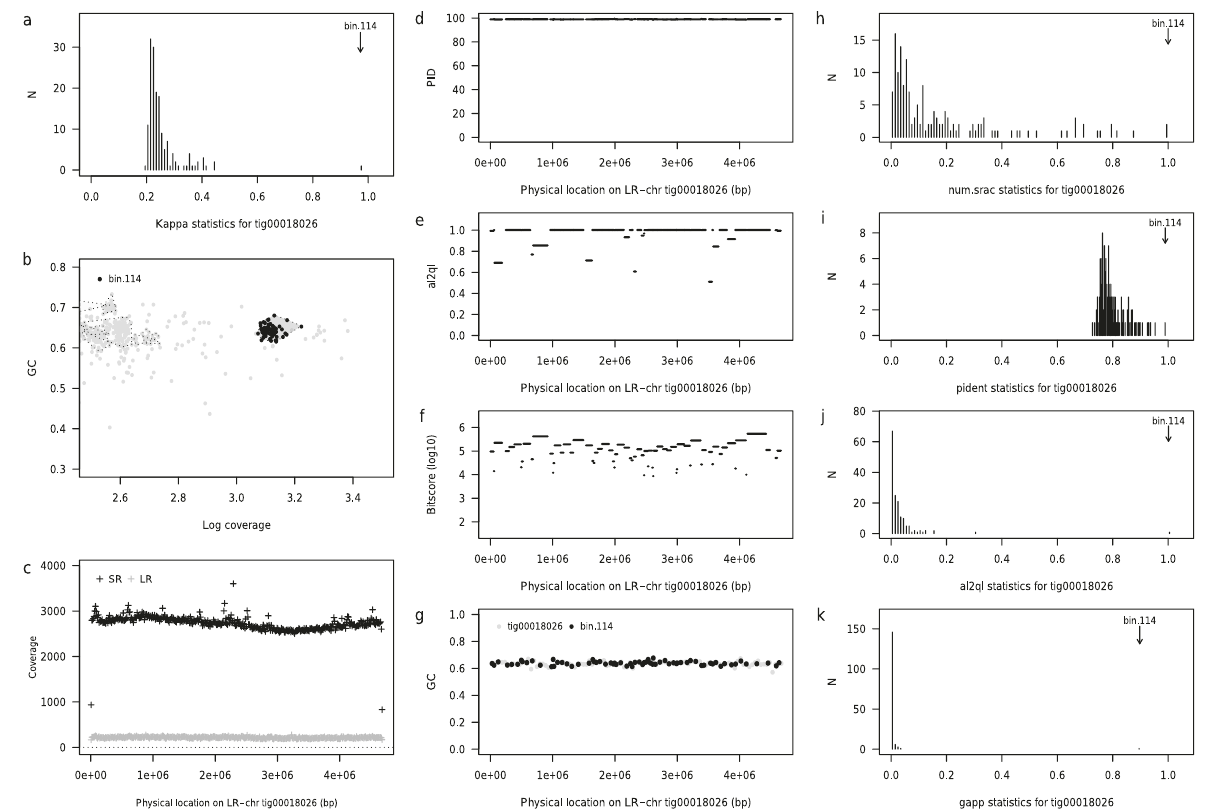
Fig. 1 Summary of concordance statistic analysis for an LR-chr ( tig00018026 ) from the PAO3A reactor community (annotated to class Anaerolineae showing close relationship to a short read metagenome-assembled genome from the same reactor community ( bin 114 ). a Distribution of κ --scores for tig00018026 against 242 bins recovered from the corresponding short read assembly. Bin 114 has the highest κ at 0.97; b coverage--GC plot for the short read assembly, with bin 114 highlighted (closed black circles and dark grey convex hull; other bins highlighted by light grey convex hulls); c short read ( SR , black crosses) and long read (LR , grey crosses) coverage pro fi les across tig00018026 . d – f BLASTN statistics for alignments of short read contigs (bin 114) against tig00018026 . Horizontal segments show alignment position on LR--chr and height of segment is value of corresponding statistic ( y --axis) namely percent identity (PID) ( d ), the ratio of alignment length to query length (al2ql) ( e ) and log 10 --bit-score ( f ). g GC content as a function of position on tig00018026 (grey closed circles, computed in adjacent windows of length 46700 bp) and for aligned short read contigs (black closed circles); h – k distribution of four component statistics of κ (see Methods), with the position of the top scoring short read bin highlighted. h proportion of short read contigs in c d pid ). j mean ratio of alignment length to query length al 2 ql and k proportion of the long bin aligned to LR--chr ( p srac ); i mean percent identity ( read contig that is covered by an alignment ( p aln